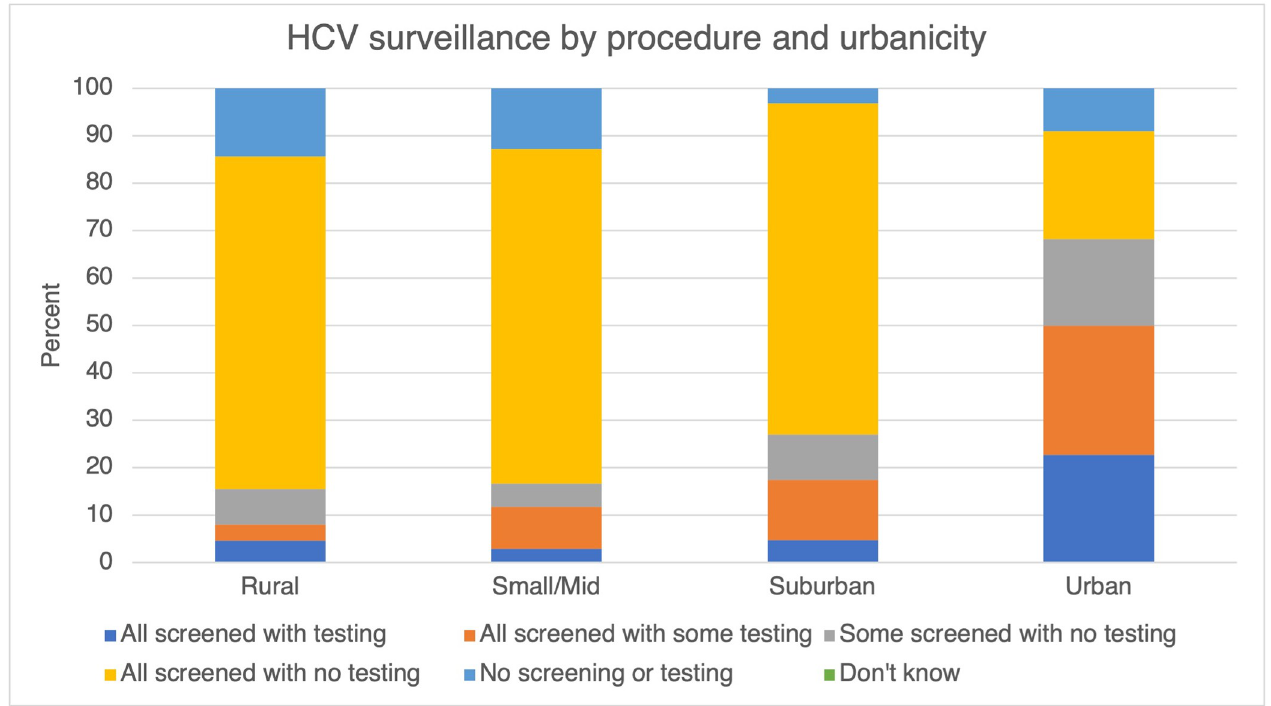
Fig 1. HCV surveillance by procedure and